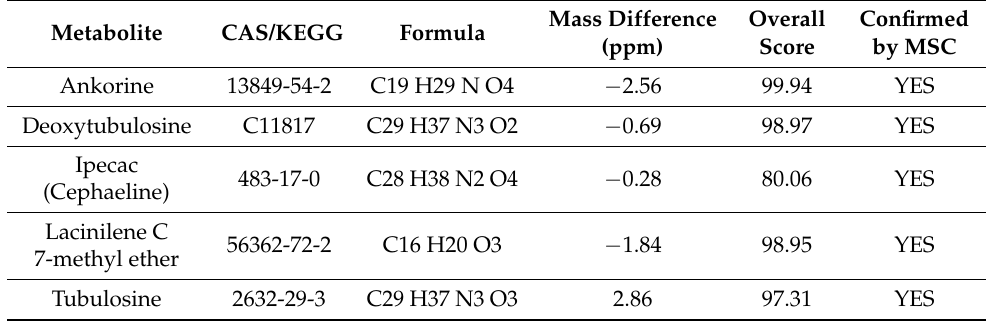
Table 4. Compounds found in Alangium species identified by Agilent MSC Software.